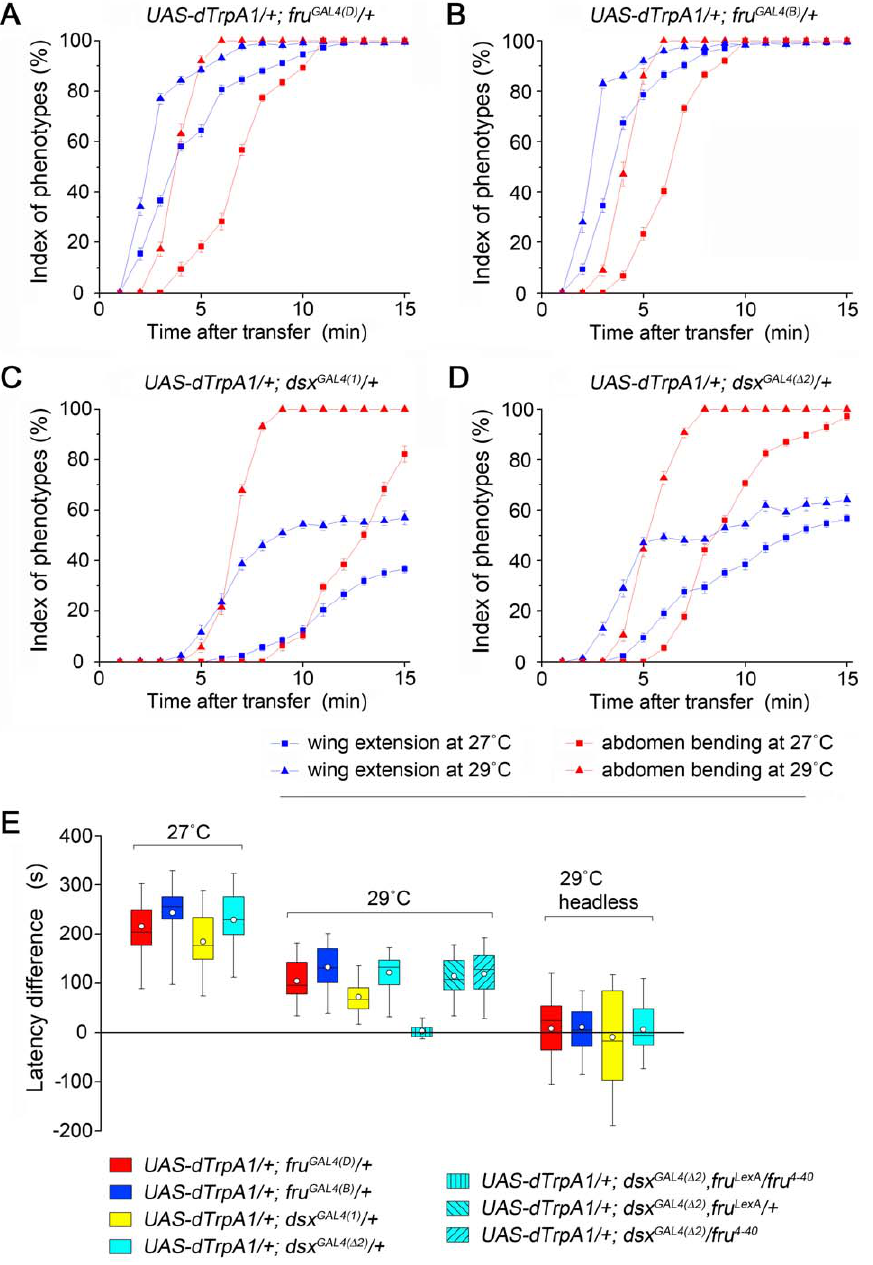
Figure 2. The sequence of courtship events is maintained in dTrpA1 -mediated courtship behaviors and dependent on FRU M . Two prominent steps of courtship behavior, wing extension and abdomen bending, were analyzed in each minute after transfer from permissive temperature (22 u C) to restrictive temperatures (27 u C and 29 u C) for 15 min. (A–D) Indices of indicated phenotype (blue: wing extension; red: abdomen bending; rectangle: 27 u C; triangle: 29 u C) are shown for each minute on continuous activation driven by fru GAL4(D) (A), fru GAL4(B) (B), dsx GAL4(1) (C) and dsx GAL4( D 2) (D). For each one-minute sample these indices were calculated as percentage of the period during which males showed an indicated phenotype. For each genotype, the index increased over time. (E) Activation of all fru M or dsx neurons induced ordered courtship behaviors. Box plots indicate how long the first abdomen bending occurred after the first wing extension. Circles indicate mean values. The middle line represents the median and the ends of the vertical lines indicate the minimum and maximum. The upper and lower edges of the boxes represent the first and third quartiles. The data indicates that wing extension is always induced before abdomen bending in solitary males regardless of temperatures (27 u C and 29 u C) or drivers (two fru GAL4 drivers and two dsx GAL4 drivers). Such order is dependent on FRU M as activating all dsx neurons in fru M null males induces wing extension and abdomen bending simultaneously. The order also lost in headless males for all four drivers. n =12 , 24 for each. Error bars in A–D indicate SEM. doi:10.1371/journal.pone.0021144.g002 results in the later steps of courtship (wing extension and vibration, action pattern requires fru M function in a group of fru M -expressing licking, and attempted copulation) occurring simultaneously [44]. neurons in the suboesophageal ganglion that project through the median bundle, as disruption of fru M function in these neurons